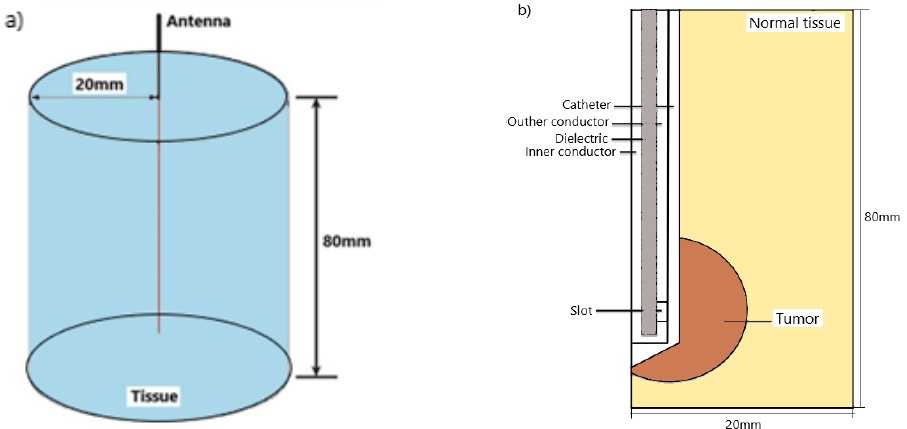
Figure 1. Schematic view of the ( a ) configuration of the antenna inserted into biological tissue used for microwave ablation therapy and ( b ) the microwave coaxial antenna enclosed in a catheter is composed of a dielectric, inner and outer conductors, and a slot. The tumor is assumed to have a spherical form.